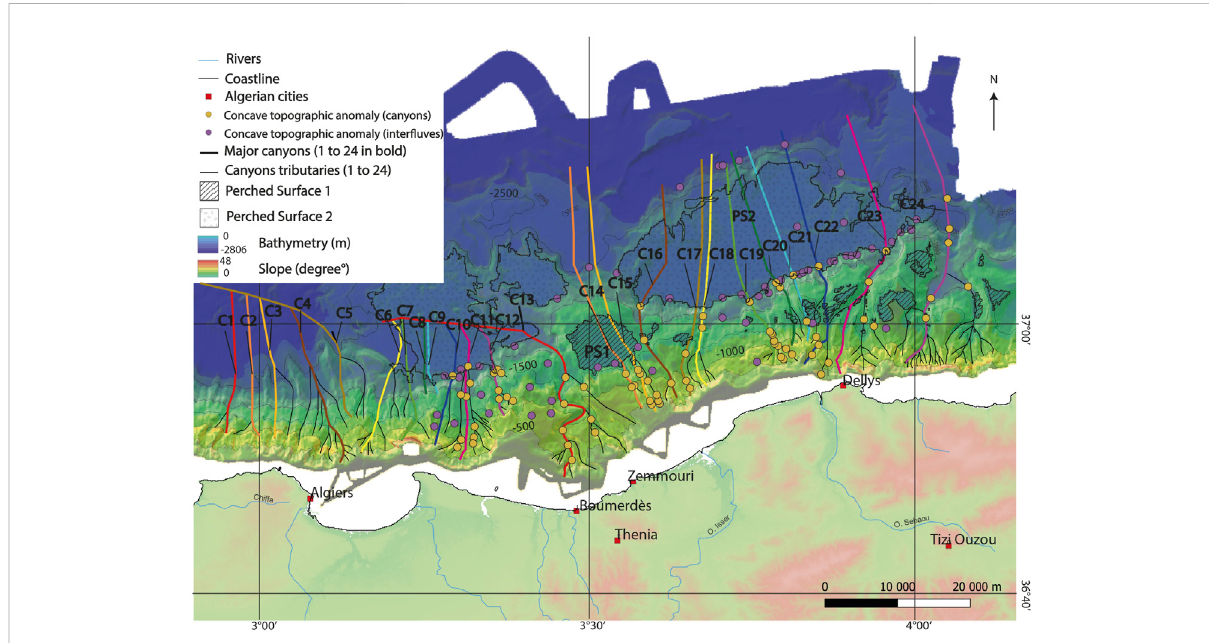
FIGURE 3 Map of classi fi ed bathymetry and of longitudinal pro fi les (thalwegs) of canyons and gullies in the area off Boumerdès. Yellow and purple circles refertomainknickpointsidenti fi edinthecanyonsandtheinter fl uvesrespectively.C1toC24arethe24longitudinalpro fi lesidenti fi edwithincanyons and gullies (Figure